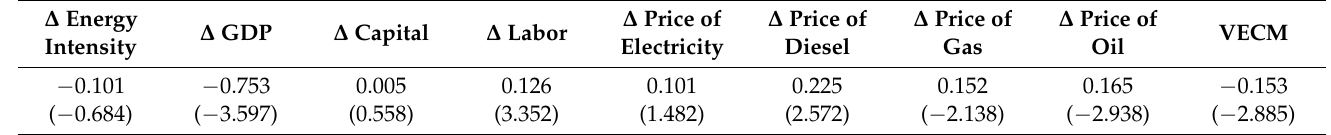
Table 9. Normalized error correction coefficients based on the energy intensity using VECM. ∆ Energy